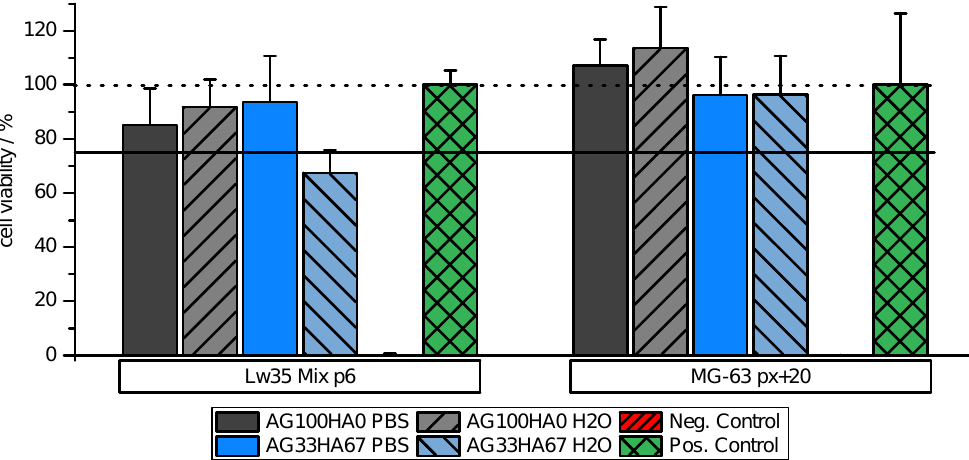
Figure 6. Cell viability of hMSCs Lw35and MG-63 cell lines on pure agarose (AG100HA0) and AG33HA67 composites. Scaffolds washed with PBS prior to MTT assay display higher cell viability. One hundred percent viability (dotted line) and 75% viability (solid line) are marked for